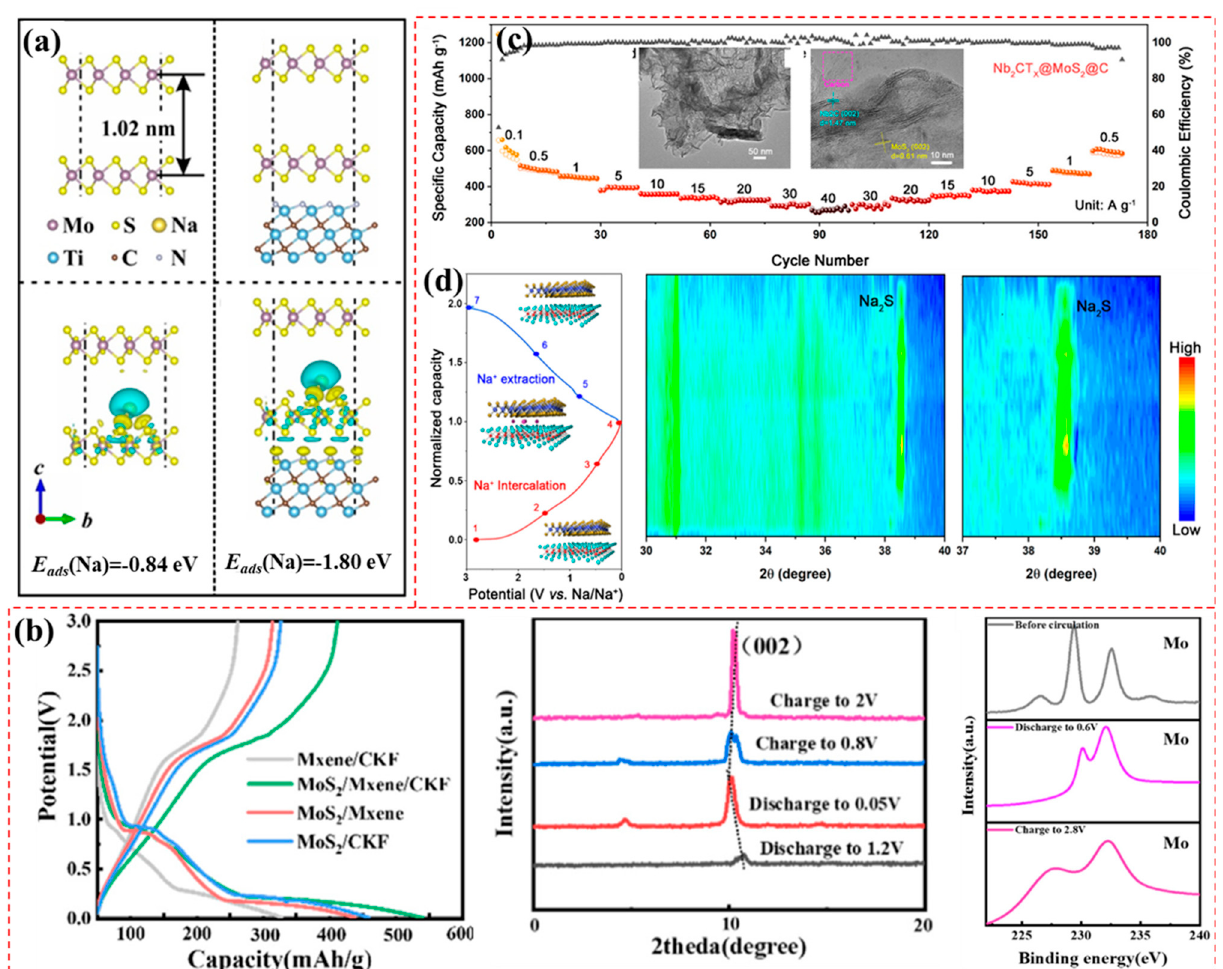
Figure 6. ( a ) The optimized structure and corresponding adsorption energy of extended MoS 2 and MoS 2 /Ti 3 C 2 (reproduced with permission from Ref. [98]; copyright 2022, Elsevier). ( b ) The initial discharge–charge profiles, XRD patterns, and XPS of a MoS 2 /MXene/CKF electrode at different depths (reproduced with permission from Ref. [87]; copyright 2022, Elsevier). ( c ) Rate performance of Nb 2 CT x @MoS 2 @C. The TEM and HRTEM images are shown in the insets. ( d ) Discharge–charge curves of Nb 2 CT x @MoS 2 @C at 0.01–3.0 V and the corresponding contour maps of the in situ XRD (reproduced with permission from Ref. [42]; copyright 2021, American Chemical